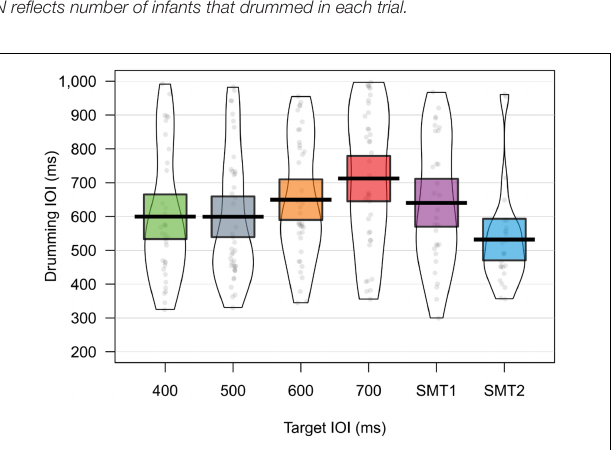
FIGURE 4 | Figure shows violin plots and jittered raw data of the rate of infant drumming in each experimental condition. The Mean is signified by a bold line, and the 95% CI is shaded. Whilst infant drumming does not directly correspond to the rate of presentation, infants appear to be adapting their rate of drumming to be slower in the slow trials (600 and 700 ms